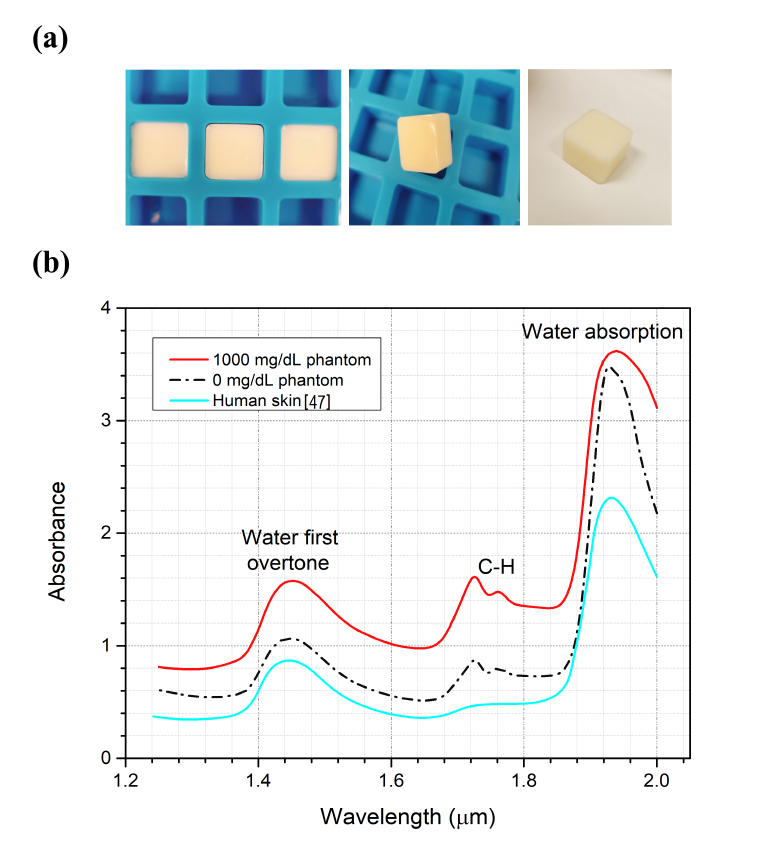
Figure 5. ( a ) Tissue-mimicking phantoms. ( b ) Absorption spectrum for the phantoms compared to the real human skin spectrum.